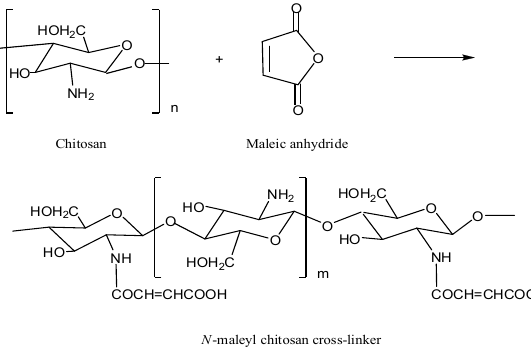
Scheme 1. Synthesis of the N -maleyl chitosan